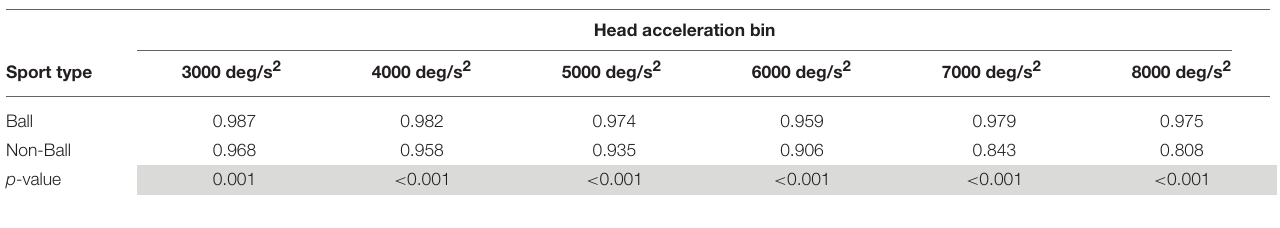
TABLE 4B | Ball vs. non-ball sports: comparisons of pca at different head acceleration bin—vertical canals.